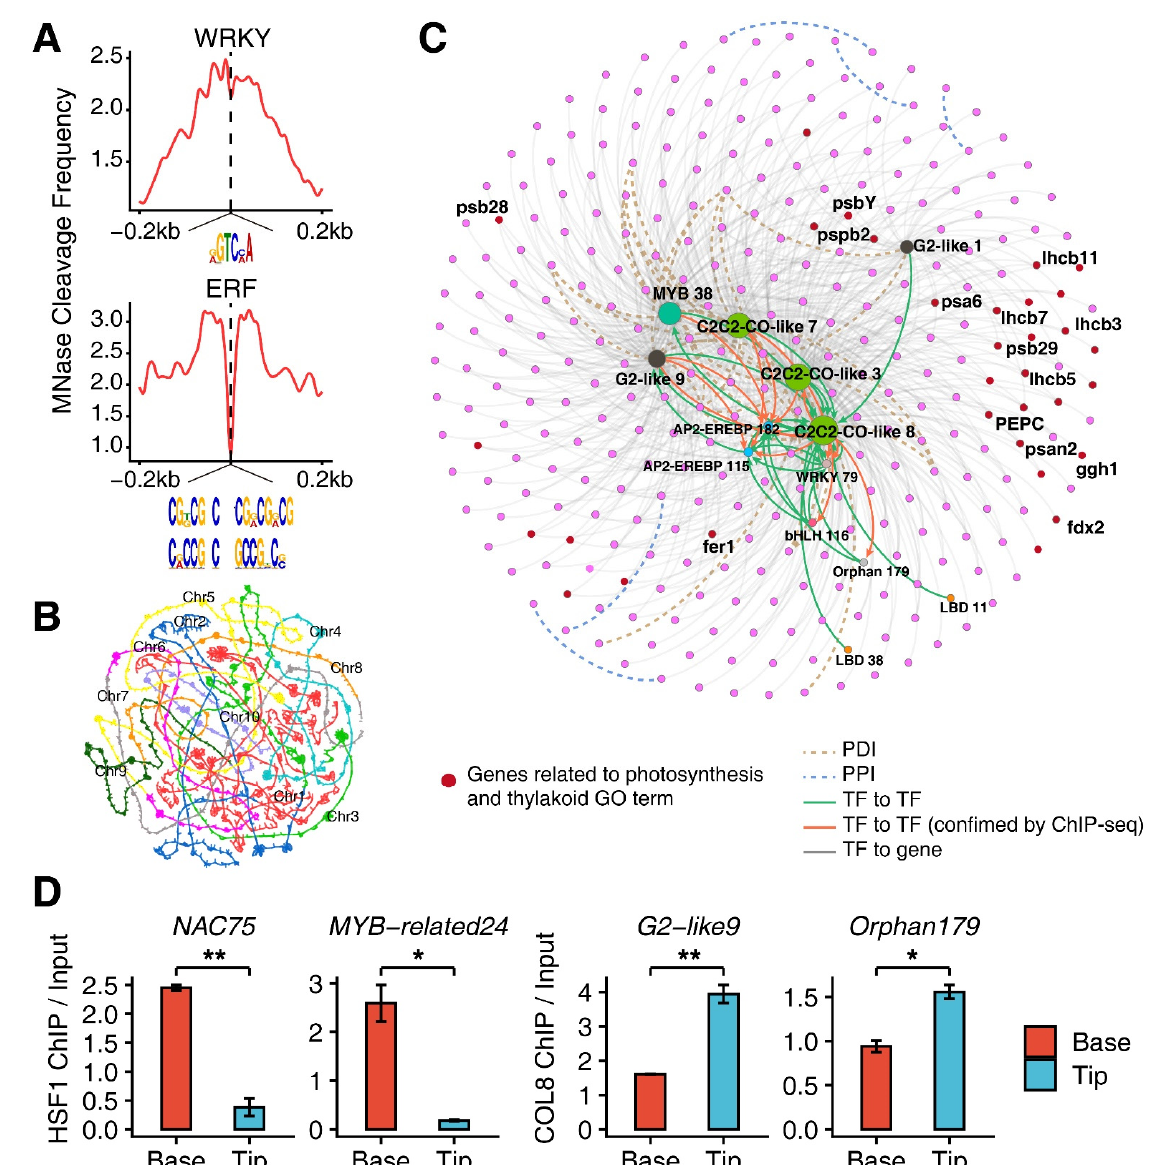
Figure 5. Construction of TF-regulatory network in M-cell development. ( A ) Footprints of WRKY and ERF TFs detected within the MNase-hypersensitive sites (MHSs), which were located within 500 bp of genes coexpressed with TFs. ( B ) Self-organized maps of chromatin interactions by H3K4me3-related loops. ( C ) The regulatory network for transcription factors and genes in Cluster 4. Green edges indicate predicted regulatory relationships between transcription factors. Orange edges indicate regulatory relationships between transcription factors confirmed by TF ChIP-seq. Grey edges indicate regulatory relationships between transcription factors and target genes. PDI and PPI mean promoter–distal interactions and promoter–promoter interactions generated from the chromatin interaction data, respectively. Genes related to photosynthesis are highlighted in the network. ( D ) ChIP-qPCR assay showing the differential binding signal of HSF1 and COL8 between the leaf bases and the leaf tips, NAC75 and MYB-related24 were targeted by HSF1 and G2-like9 and Orphan179 were targeted by COL8. The ChIP enrichment levels for NAC75 and MYB-related24 were presented as mean ± SD from two biological replicates, and for G2-like9 and Orphan179 were presented as mean ± SD from three technical replicates. Significance test was determined using one-sided t -test, * indicates p < 0.05, ** indicates p <